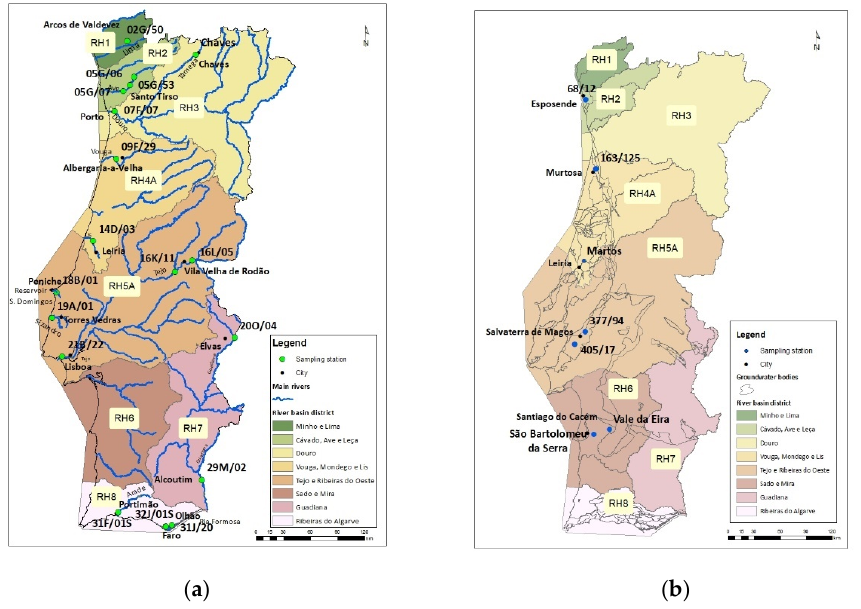
Figure 1. ( a ) Surface-water sampling sites; ( b ) groundwater sampling sites. Maps provided by the Portuguese Environmental Agency. Portuguese Environmental